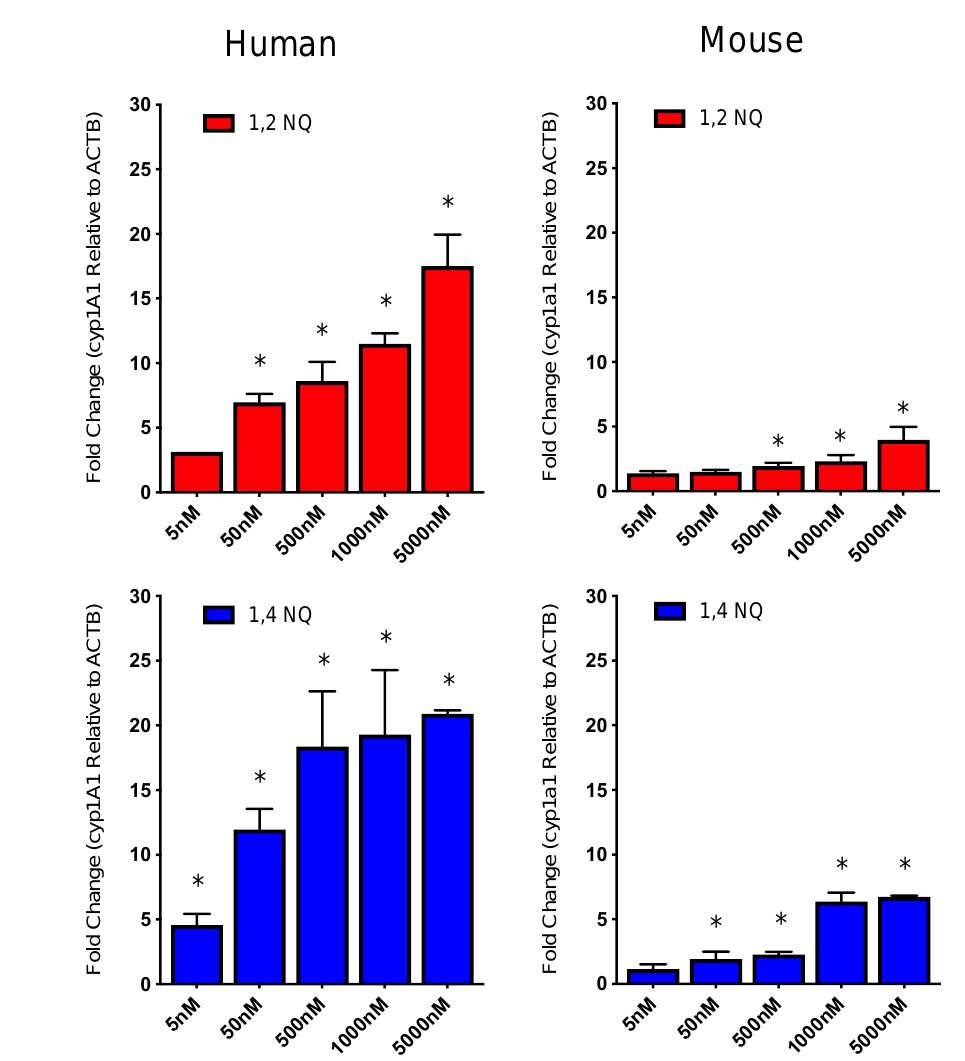
Figure 2. 1,2-NQ and 1,4-NQ induce CYP1A1 / cyp1a1 mRNA in mouse and human hepatoma cells. Human HG2L7.5c.1 and mouse H1L7.5c.3 hepatoma cells were incubated with DMSO (1% v / v ), 1,2-NQ (5 nM–5 µ M) or 1,4-NQ (5 nM–5 µ M). After 4h incubation, cells were harvested with TRIzol reagent, RNA isolated, cDNA reverse transcribed and CYP1A1 / 1a1 mRNA transcripts quantitated